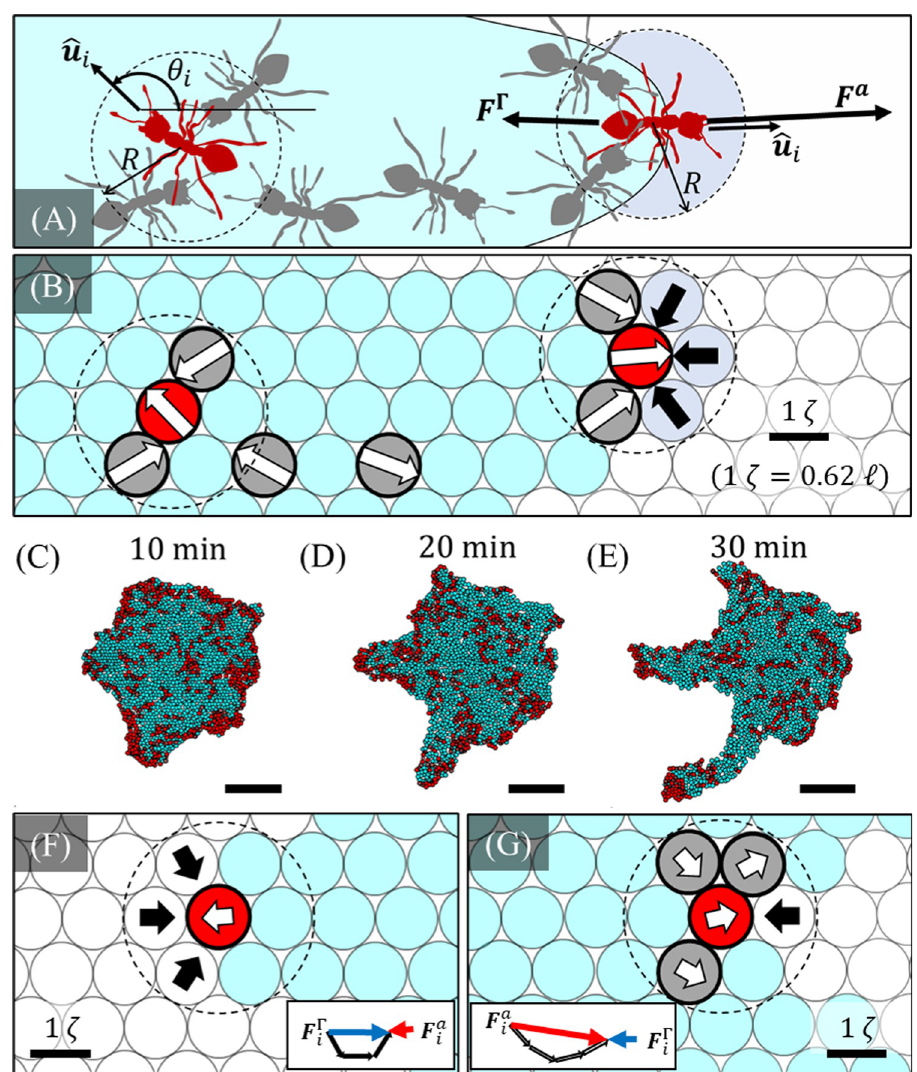
Fig 2. Agent-based Model Schematic. (A) Two free ants of interest (red) are schematically illustrated on a structural section of raft (shaded cyan) in continuous space. Other free ants are shaded grey. The direction of motion ( ^ u ¼ ½ cos y ; sin y � ) of the ant far from the edge of the raft (left) is predicted entirely by the Vicsek model. In contrast, i i i whether the ant encountering the edge of the raft (right) moves into the water, depends not only on ^ u , but also on the i competition between active force F a and the effective edge repulsion force F G . Each of these forces is governed by the i i motion of free ants and relative position of water within detection distance R of the ants. (B) A corresponding schematic envisions how these continuous scenarios are coarse-grained into the lattice-based framework of the numerical model. The motion of the free agents of interest (red) remains governed by the direction of travel (white arrows) of neighboring free agents, and effective pairwise repulsion (black arrows) from neighboring water nodes within distance R . However, free agent movement is updated by stepping the free agents to the adjacent structural . Nodes agents (cyan) or water nodes (white) whose relative direction most closely matches the preferred direction, θ i are displayed in a hexagonal, close-packed lattice for illustrative purposes only, but are initially offset in both directions of the horizontal plane by some amount in the range z and are further randomized by stochastic structural unbinding events as the simulation progresses. (C-E) The shape evolution of a simulated raft over a duration of 20 min (of virtual time), illustrates the implementation of the lattice-based conceptualization from (B) into the numerical model. Shape change is governed by the transition of free agents (red) into the structural network (cyan) at the raft’s edge. The raft depicted was initiated as a circle and all scale bars represent ℓ . ( F-G ) Agents encountering water in regions of ( F ) high and ( G ) low edge curvature are depicted. These respective agents experience high and low values of F Γ due to the pairwise contributions of repulsion force from detected water nodes (black arrows). The agent in ( F ) has no freely active neighbors such that the only contribution to its value of F a is its own self-propulsion force (white arrow), whereas the agent in ( G ) has many freely active neighbors moving in similar directions towards the water such that